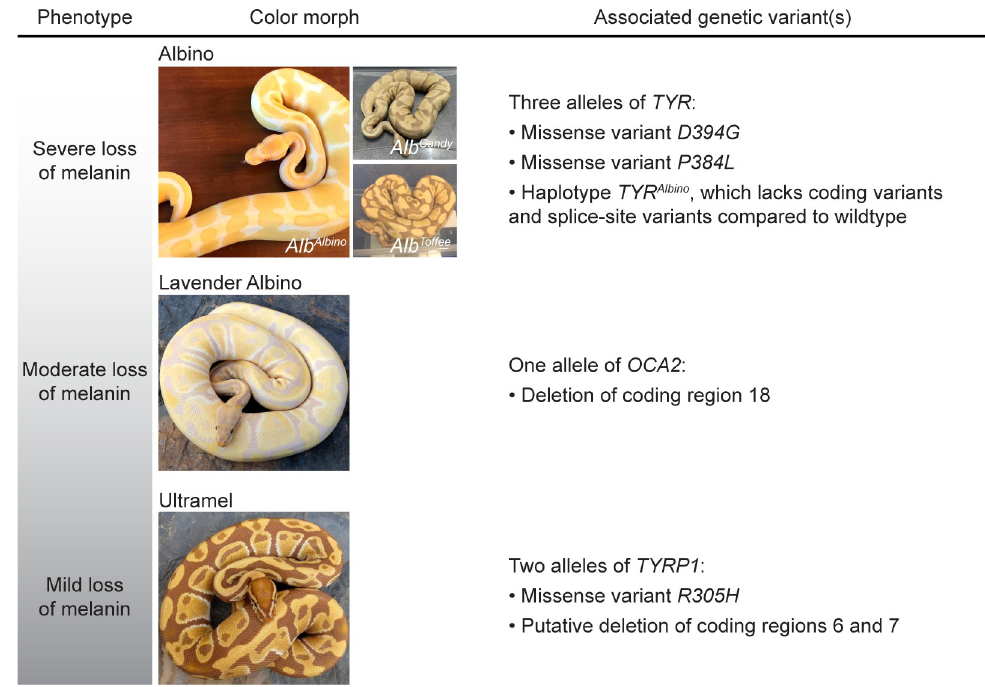
Fig 5. Summary of genetic variants associated with the Albino, Lavender Albino, and Ultramel color morphs. Photo credits, Ryan Young of Molecular Reptile, Chiron Graves, Phil Barclay, Michael Freedman of The Florida Reptile Ranch.